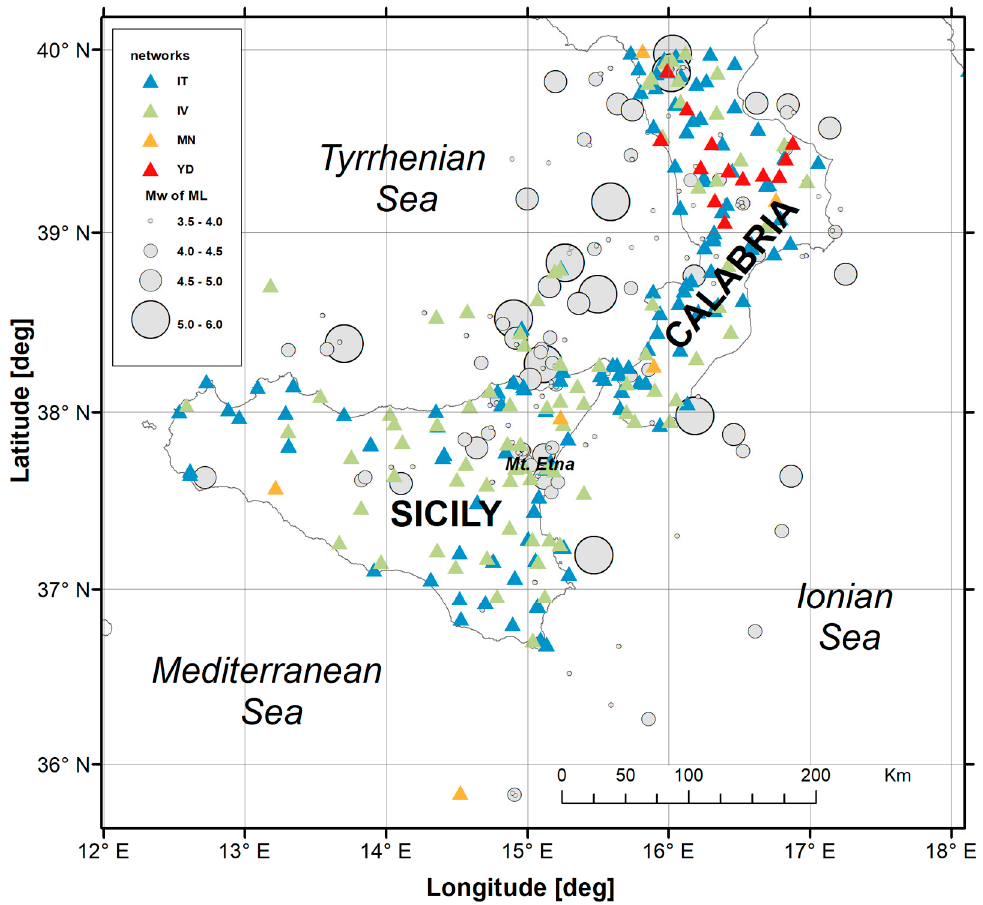
Figure 5. Map of southern Calabria and Sicily showing the epicenter locations grouped by magnitude range, and the recording stations (~230) that belong to different networks (IT: Rete Accelerometrica Nazionale; IV: Italian National Seismic Network, INSN; MN: Mediterranean Very Broadband Seismographic Network; YD: Calabria-Appennine-Tyrrhenian/Subduction-Collision-Accretion